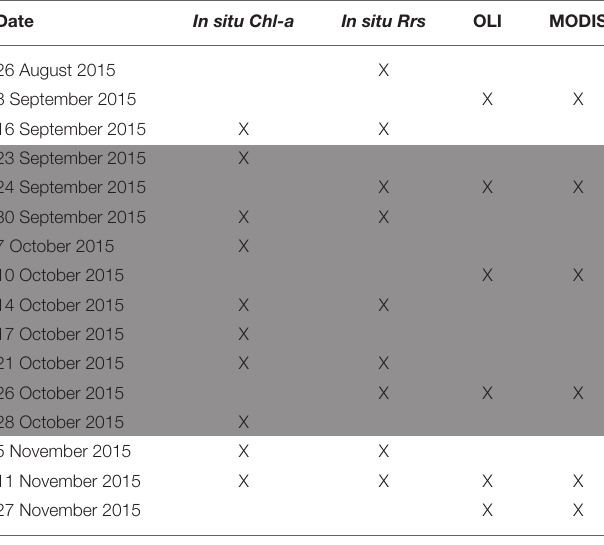
TABLE 1 | In situ and remote sensing sampling dates before, during, and after the wastewater diversion event in Santa Monica Bay. In situ Chl-a In situ